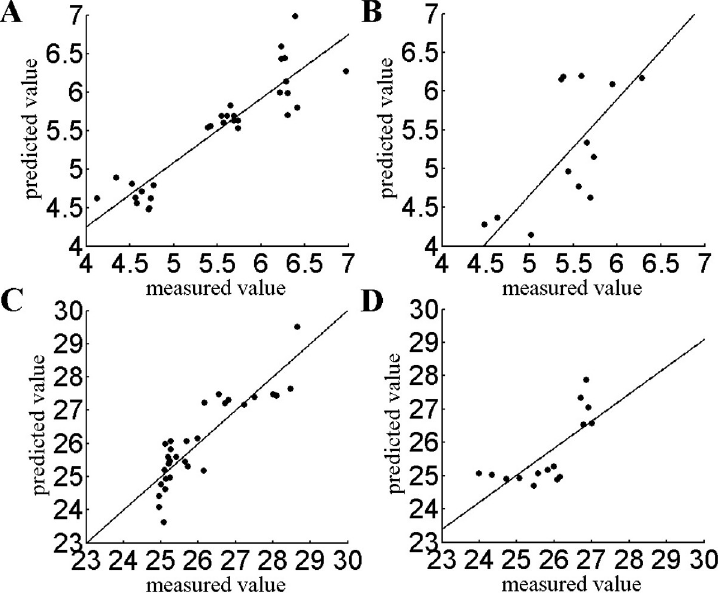
Fig 2. Establish the MLR model for the bitter and astringent taste of tea. a. Calibration set for the bitter taste of tea b. Prediction set for the bitter taste of tea c. Calibration set for the astringent taste of tea d. Prediction set for the astringent taste of